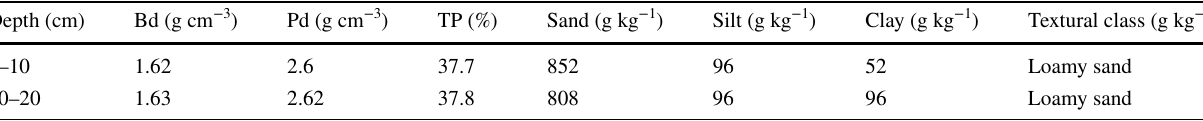
Table 3 Physical analysis of Dystric Xeropsamments with long-term organic fertilization